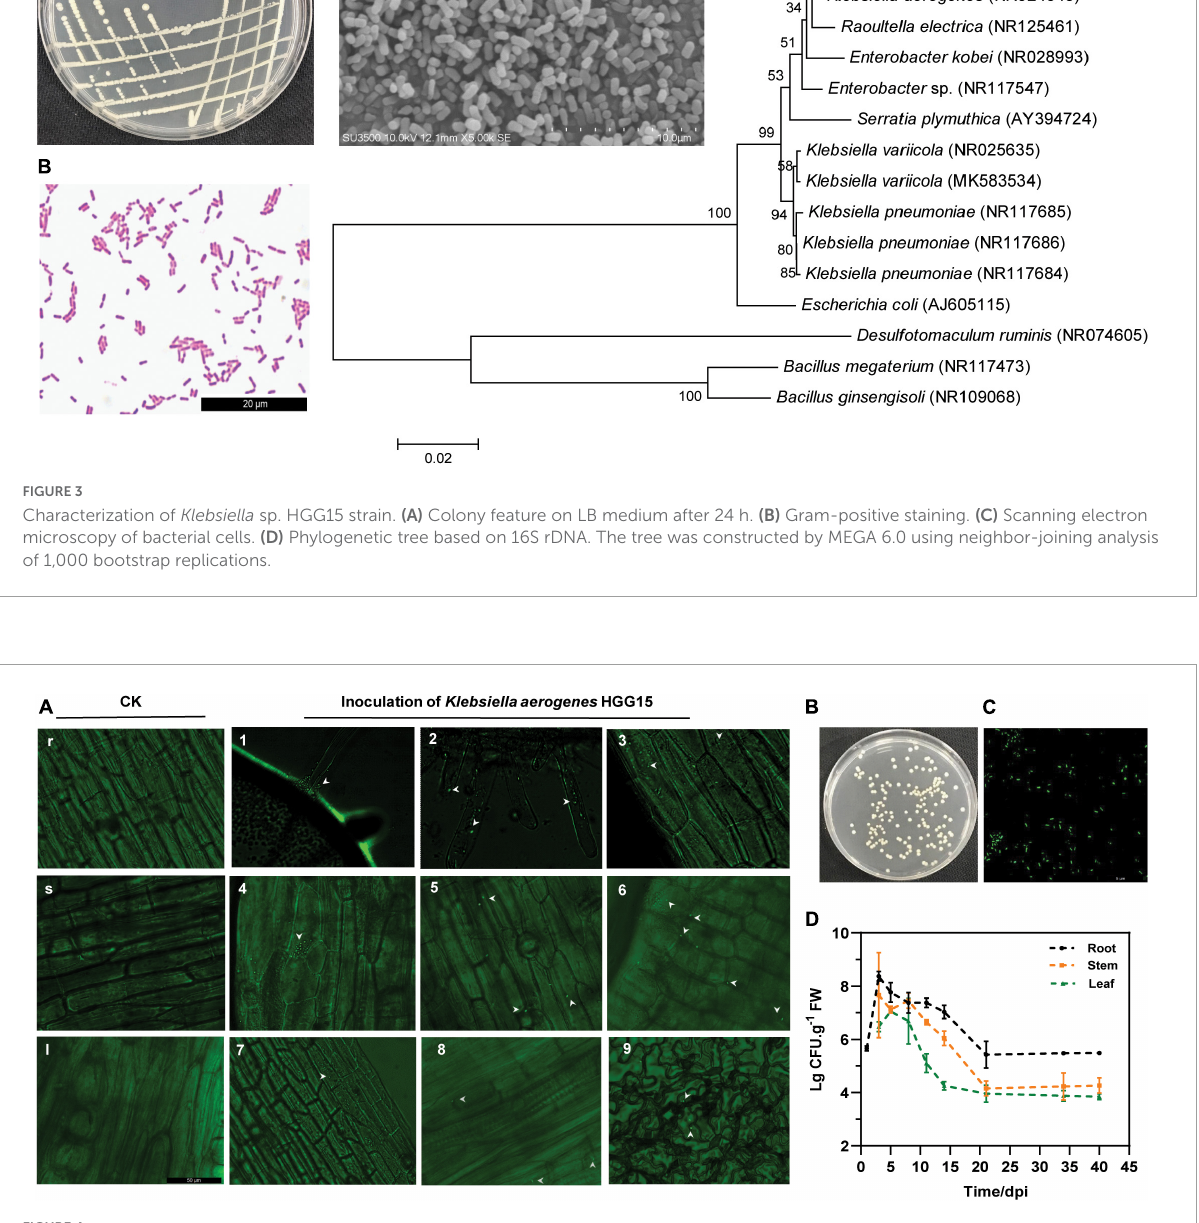
FIGURE4 Colonization and population dynamics of gfp-tagged K. aerogenes HGG15 in mulberry seedlings. (A) Infection and colonization of gfp-tagged K. aerogenes HGG15 in mulberry. r, mulberry root of control group in 1 dpi; s, mulberry stem of control group in 3 dpi; I, mulberry petiole of control group in 7 dpi; 1, mulberry root hair of inoculation group in 1 dpi; 2, mulberry lateral root of inoculation group in 1 dpi; 3, mulberry root epidermis of inoculation group in 2 dpi; 4–6, mulberry cortex of inoculation group in 3–5 dpi; 7–8, mulberry petiole of inoculation group in 7 dpi; 9, leaf epidermis of inoculation group in 12 dpi. (B) Cultural feature of gfp-tagged K. aerogenes HGG15 re-isolated from mulberry on LB medium containing 50 µ g/mL kanamycin. (C) Observation of re-isolated gfp-tagged K. aerogenes HGG15 strain under green fluorescence at 488 nm. (D) Population dynamics of gfp-tagged K. aerogenes HGG15 in mulberry